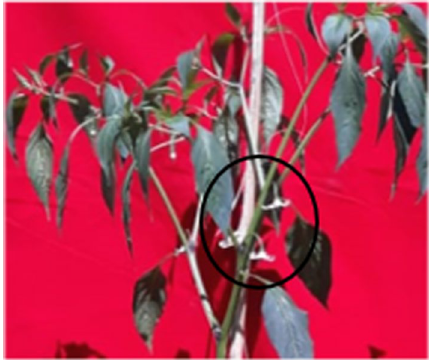
Fig. 2 The first flower appears on chili plants introduced by isolates of actinobacteria code ARAI 3221 (42 DAP)